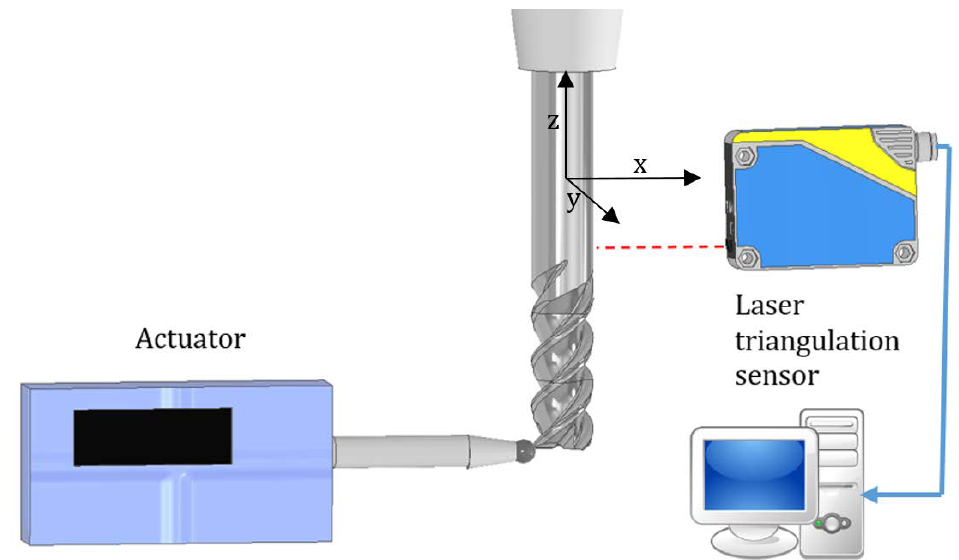
Figure 4. Scheme of the workpiece measuring station along the z axis.